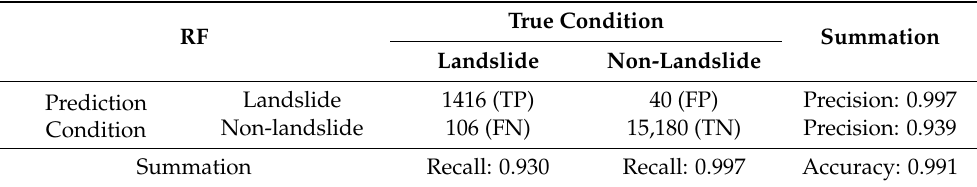
Table 5. Confusion matrix of landslide comprehensive susceptibility.